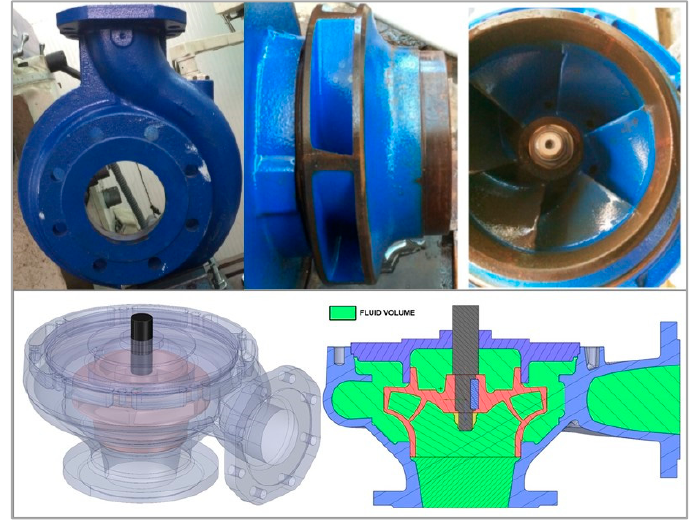
Figure 1. Geometry and fluid volume.